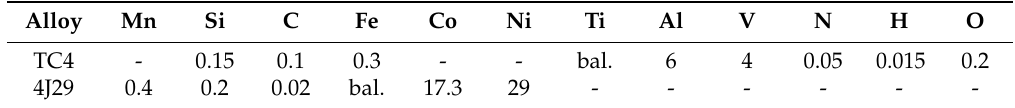
Table 1. Chemical composition of base metals (wt %).